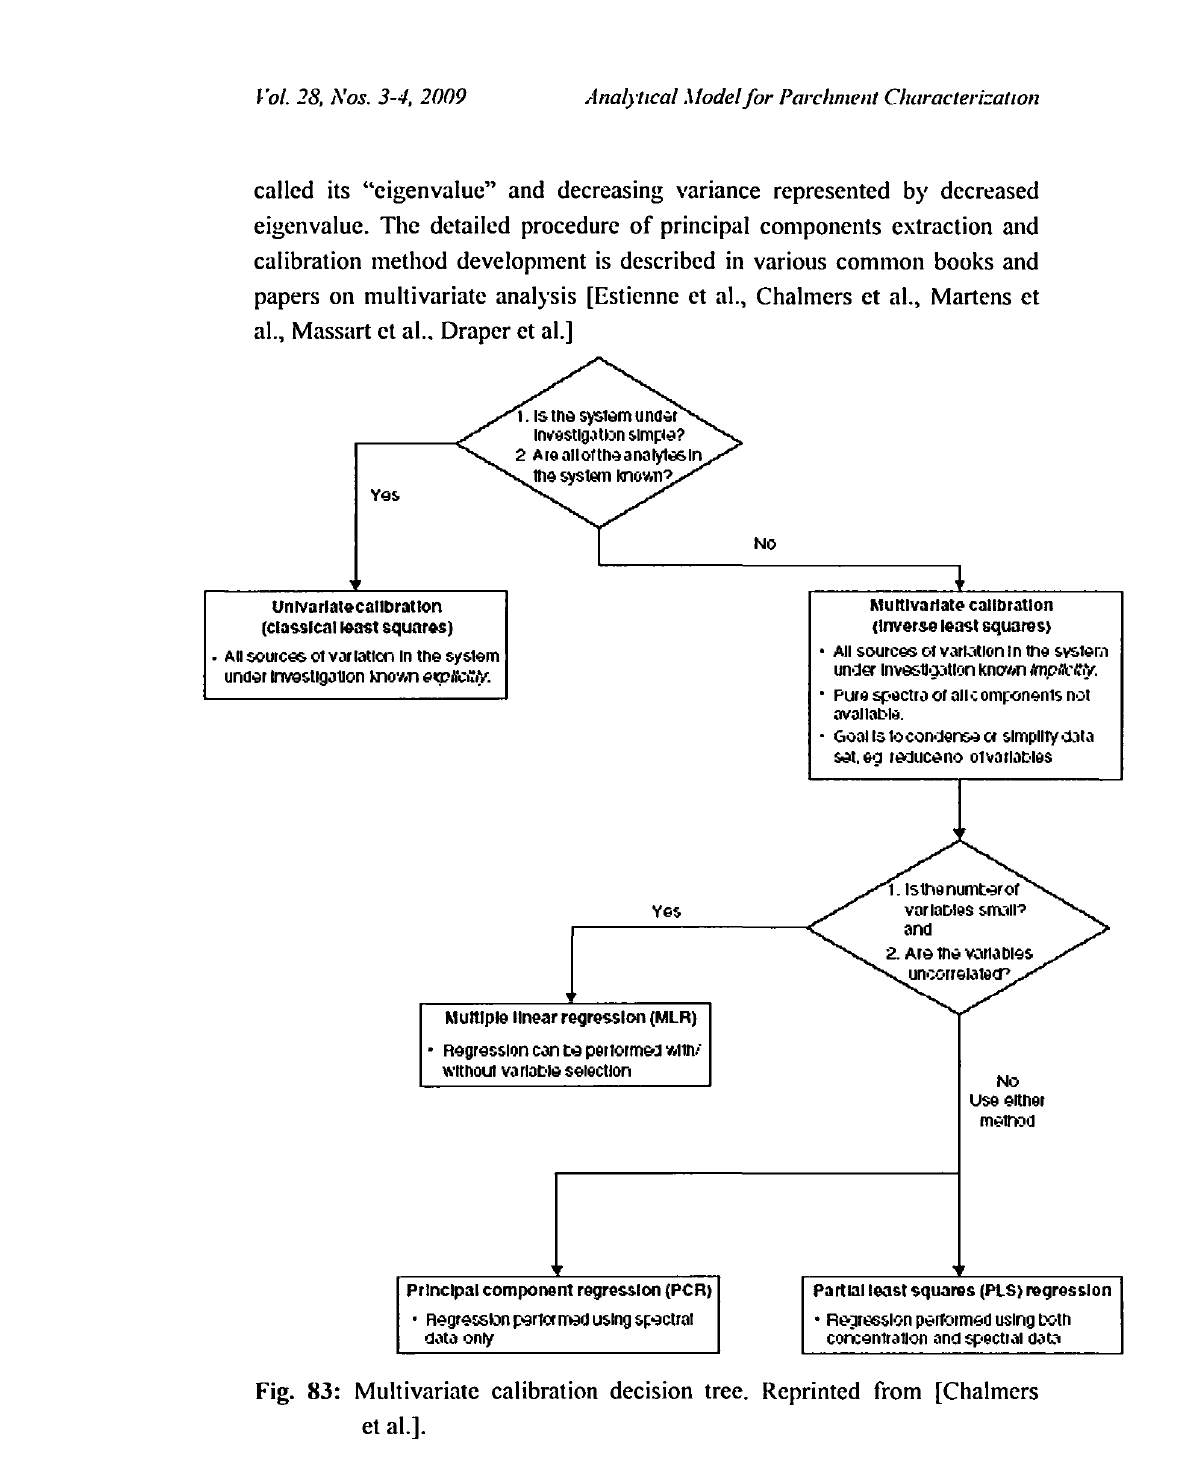
Fig. 83: Multivariate calibration decision tree. Reprinted from [Chalmers et